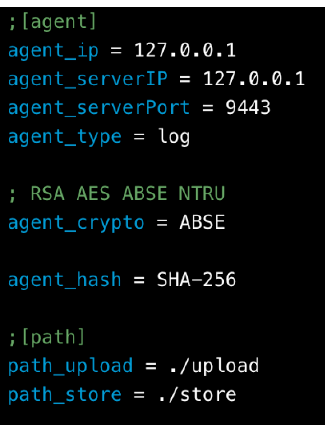
Figure 12. Device configuration.